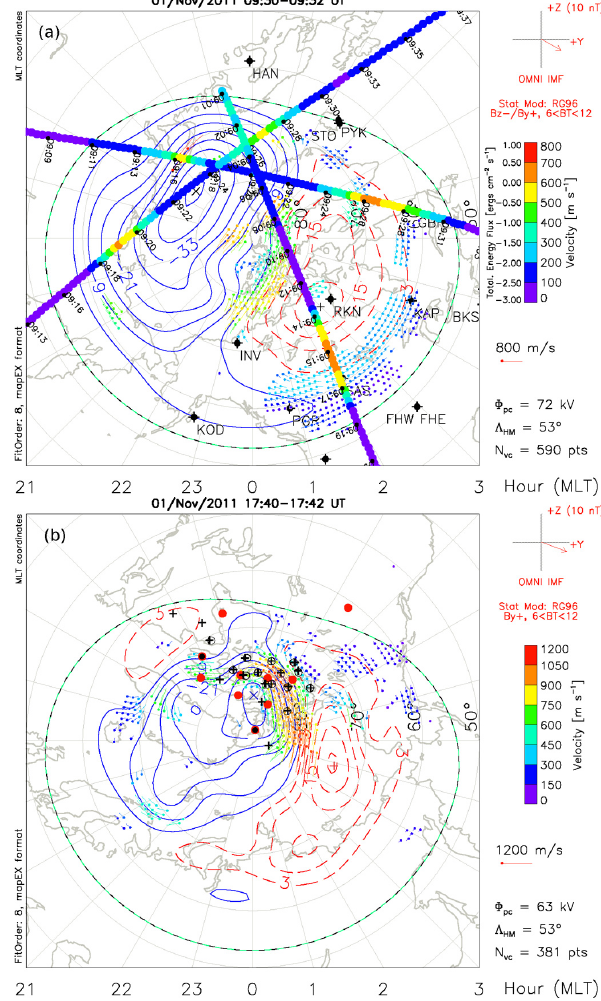
Fig. 5. SuperDARN convection and potential map showing (a) mod- erate flows in the polar cap and midnight-to-dawn auroral zone, as well as weakened SAPS observed at 09:30UT overlaid with three passes of POES satellites that observed auroral precipita- tion between 09:00 and 09:35UT, and (b) fast convection in the throat region through the cusp where TOI caused intense scin- tillation. CHAIN (red dots) and IGS stations (black dots) along with IPPs where scintillation index σ 8 > 0 . 1 radians (open circles) and/or DPR > 2mms − 1 (crosses) were observed between 17:40 and 17:42UT, are